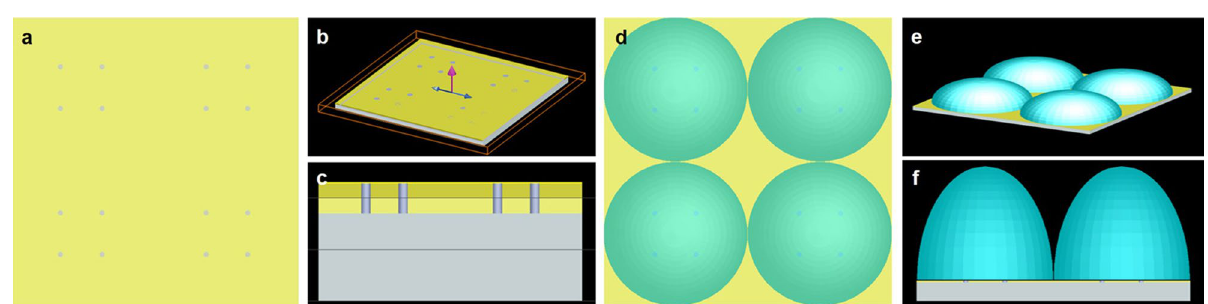
Figure 2. Numerical analysis model of nanopore array ( a – c ); Numerical analysis model of nanopore-microlens array ( d – f